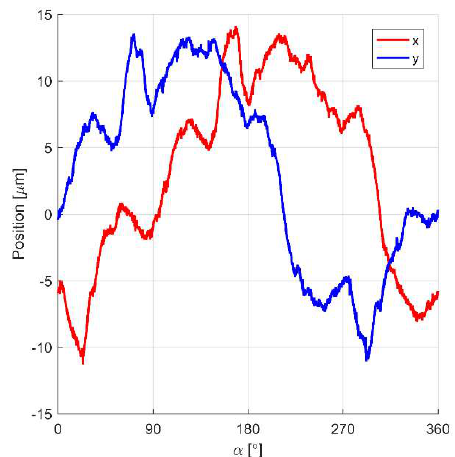
Figure 11. Error signals obtained from the sensors in the x - and y -axis during slow rotation of the rotor without the control system.